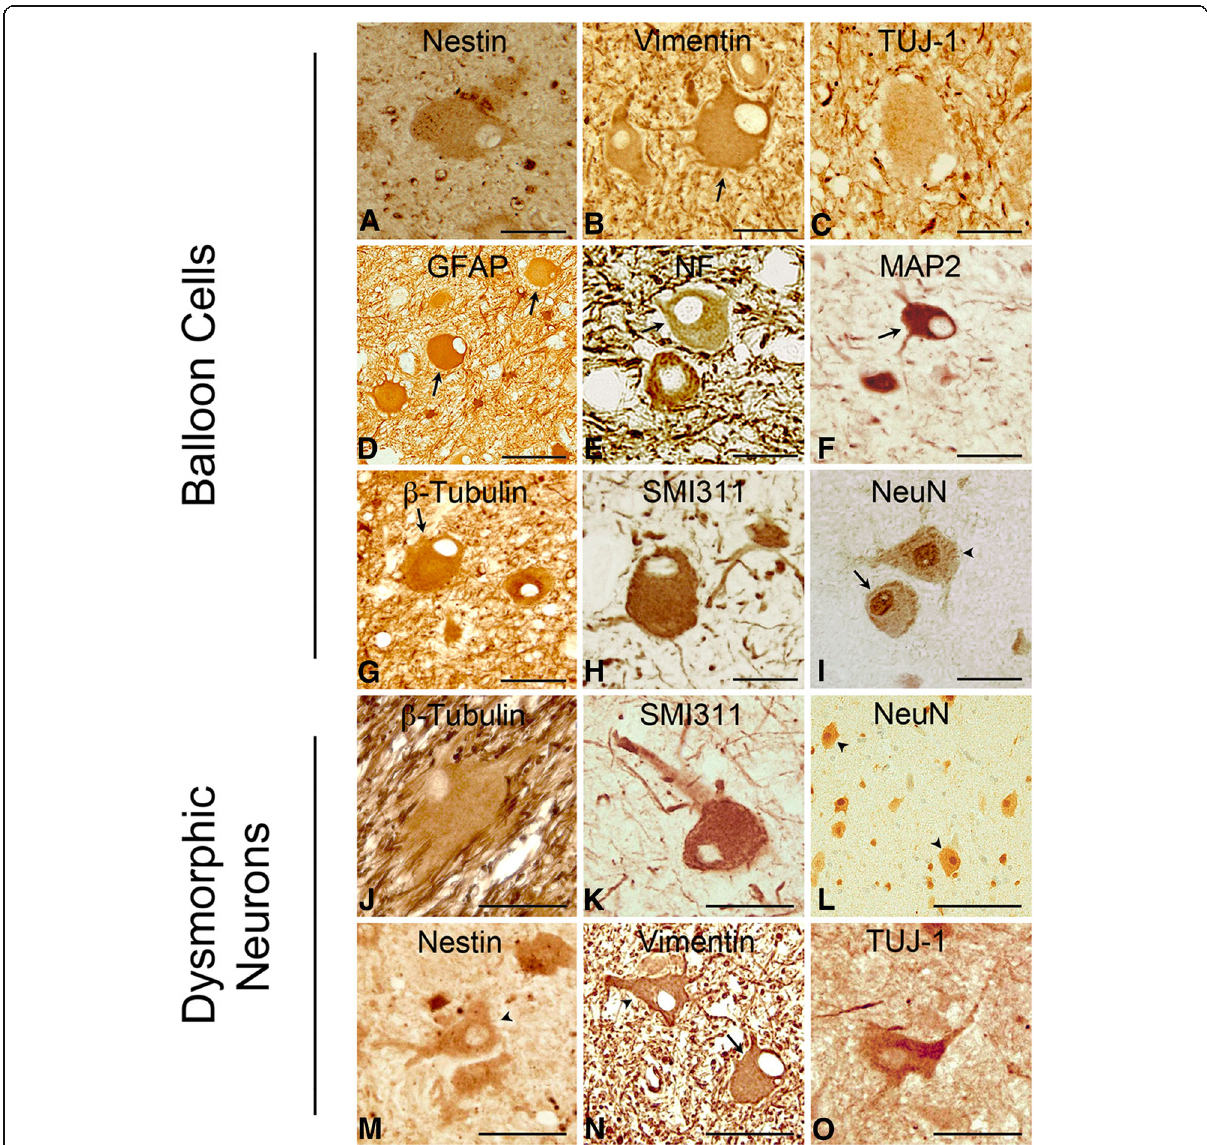
Fig. 3 Balloon cells, dysmorphic and hypertrophic neurons presented characteristics of undifferentiated and mature cells. BCs were decorated by antibodies against nestin ( a ), vimentin ( b ; arrow in n ) and TUJ-1 ( c ), which are usually expressed by undifferentiated neural cells. BCs expressed GFAP at a variable intensity or not at all ( d ). BCs were also marked by antibodies against neurofilament proteins (arrow in e ), MAP2 ( f ), β -tubulin ( g ), pan-neuronal filaments ( h ), and NeuN (arrow, i ). DNs were stained by anti- β -tubulin ( j ), SMI 311 ( k ), and anti-NeuN (arrowheads in l ). DNs were also marked by anti-nestin ( m ), anti-vimentin ( n ), and anti- neuronal class III β -tubulin ( o ). HyNs were stained with the anti-NeuN antibody (arrowhead in i ). Cases: 10, a, c, d, e, g, h, i, j, k, l, o ; 9, b , m, n ; 5, f . Bars, 30 μ m for all panels, except for panel ( d ), 50 μ